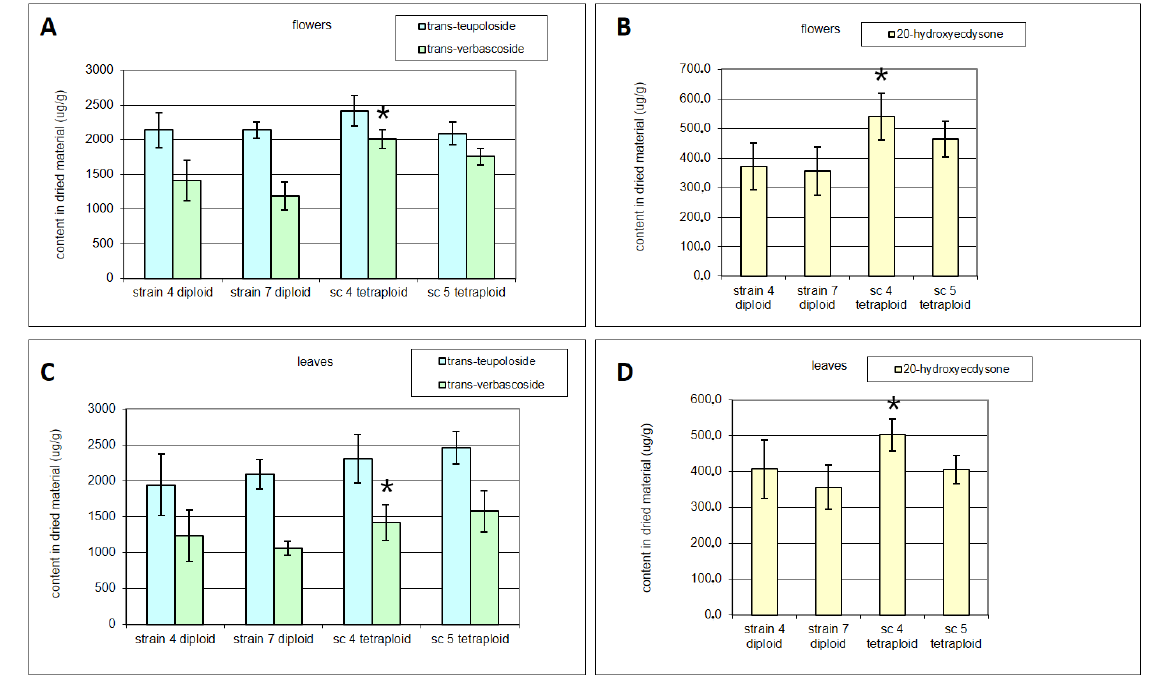
Figure 3. Contents of glycosides trans -teupolioside, trans -verbascoside ( A , C ) and 20-hydroxyecdy- sone ( B , D ) measured in dried flowers ( A , B ) and leaves ( C , D ) of two progenitor strains (7 and 4) and in tetraploid strains derived from those progenitors. Asterisks (*) mark significant differences of substances content in tetraploids in relations to its diploid progenitors ( p value < 0.01).